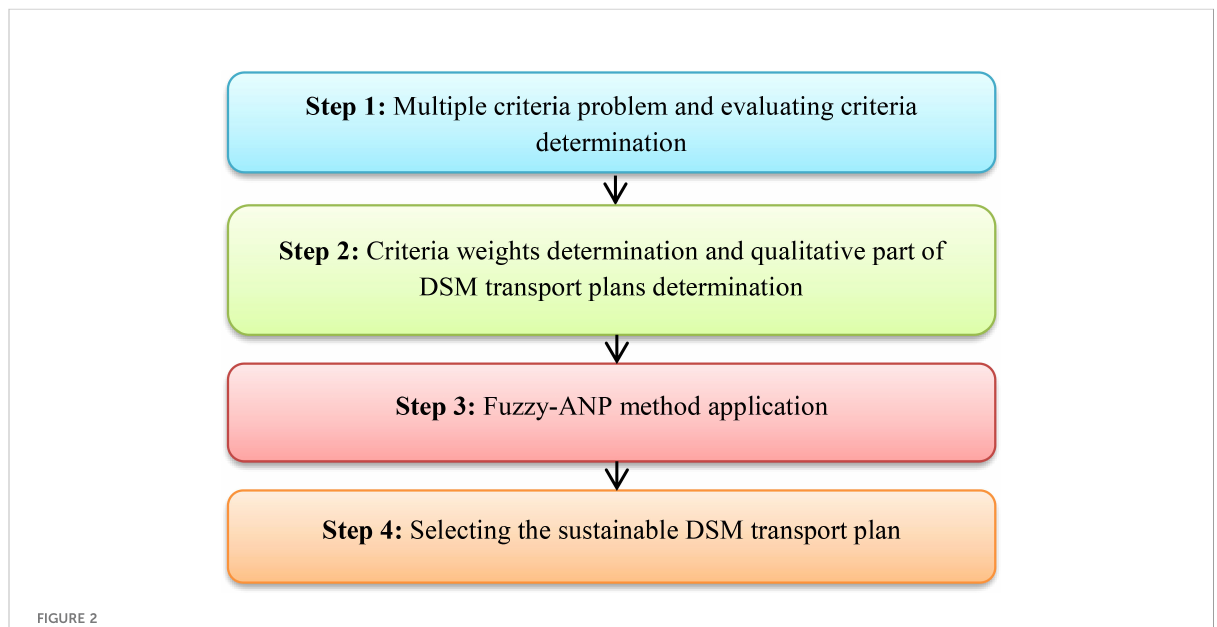
FIGURE 2 Application procedure of Fuzzy-ANP methodology in sustainable DSM transport plan